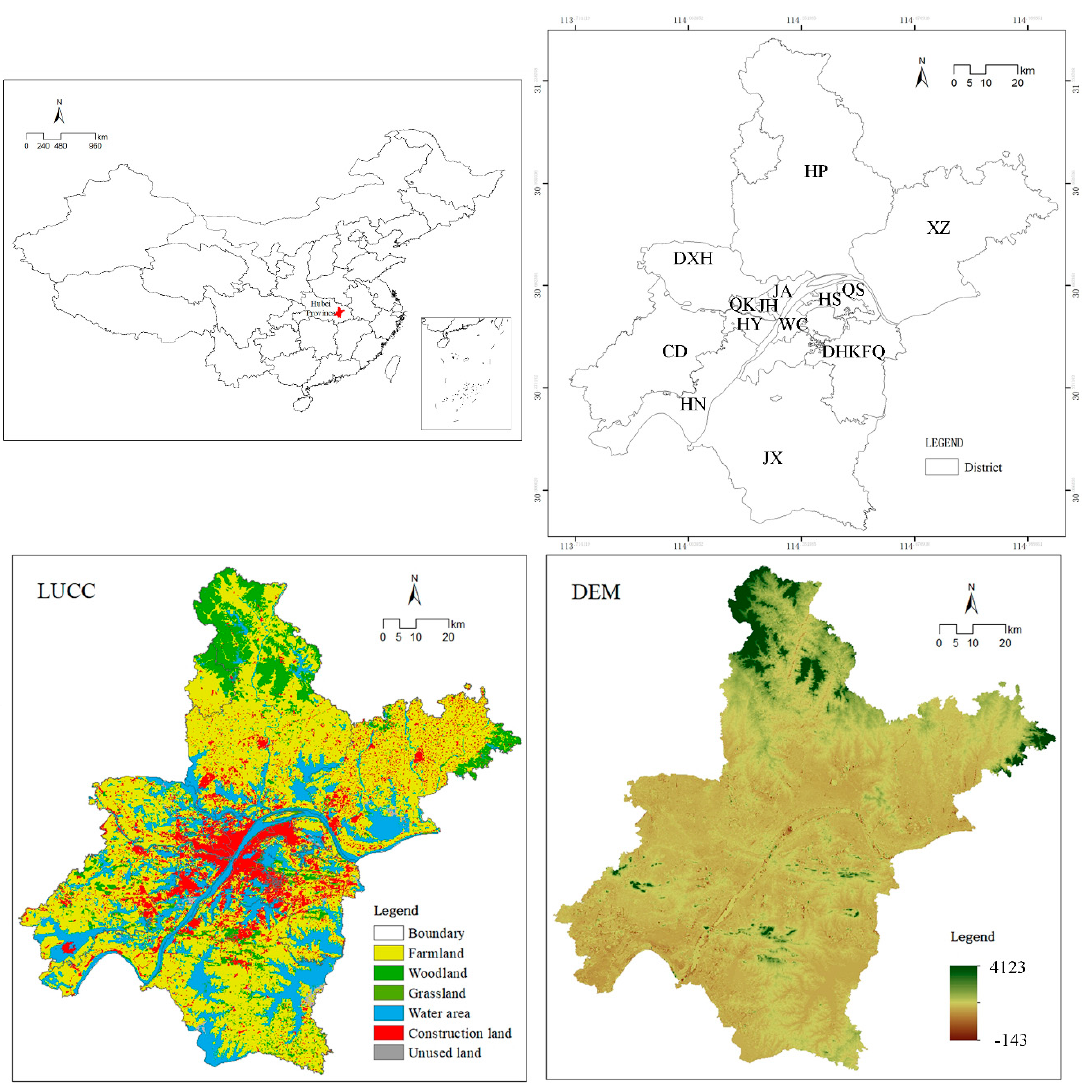
Figure 1. The study area of Wuhan City. Abbreviations: JX—Jiangxia, HS—Hongshan, WS—Wuchang, JA—Jiang’an, HP—Huangpi, CD—Caidian, JK—Jingkai, HY—Hanyang, QK—Qiaokou, JH—Jianghan, QS—Qingshan, XZ—Xinzhou, and DXH—Dongxihu.